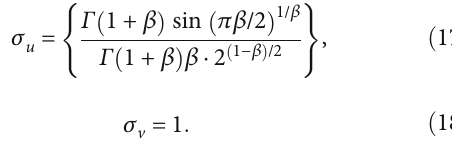
location in the arti fi cial bee colony algorithm. The cuckoo search algorithm is a new metaheuristic search algorithm.